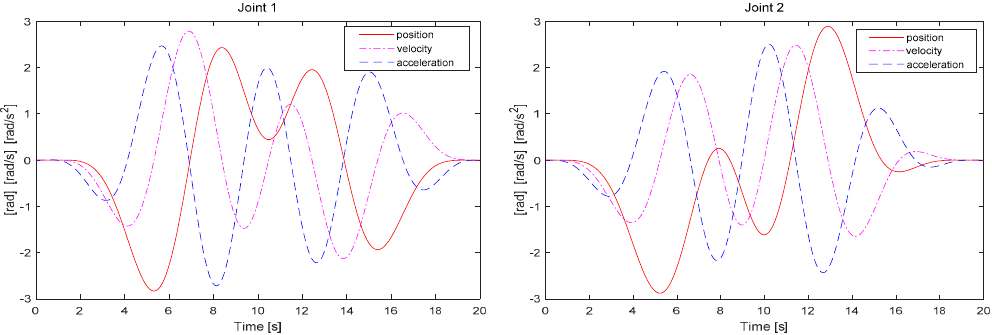
Figure 5. Condition number versus trajectory points for the actual 2-DOF manipulator.